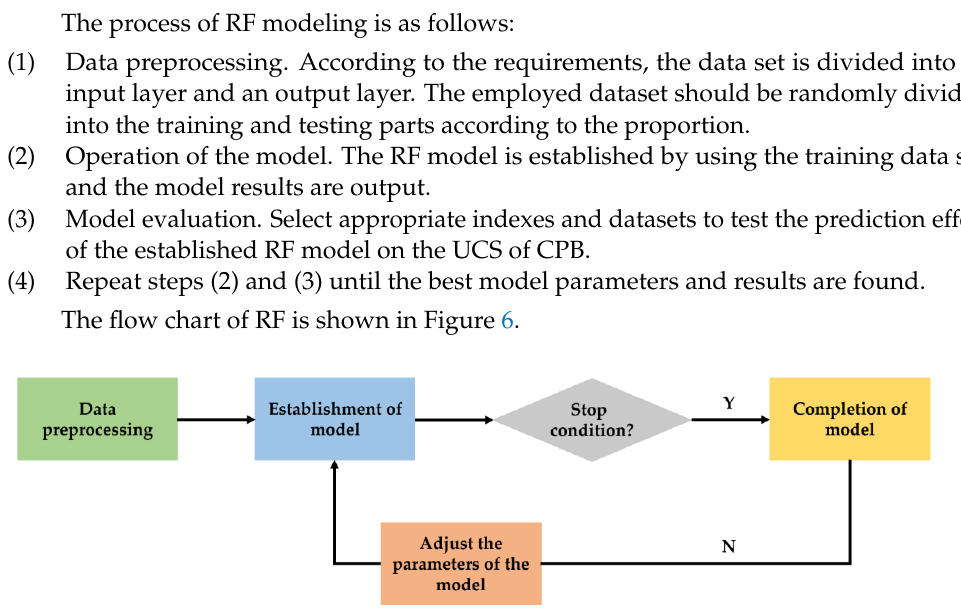
Figure 5. Flow chart of RF.